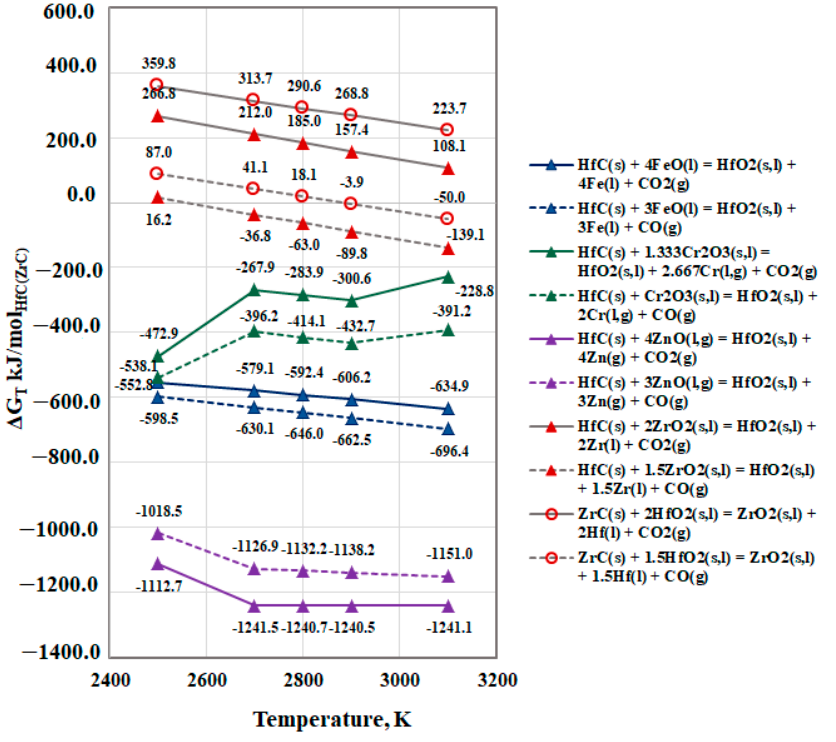
Figure 6. Free energy for interaction between HfC(s) and oxides of metal impurities in vacuum.